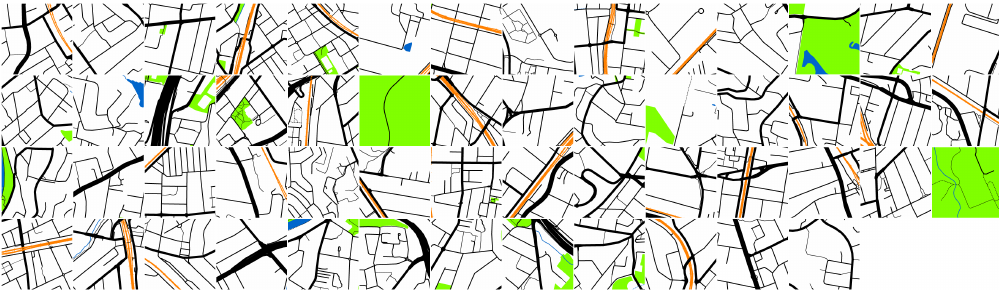
Figure 7. Gallery of “Paris-like” locations in Sydney using the GM neural